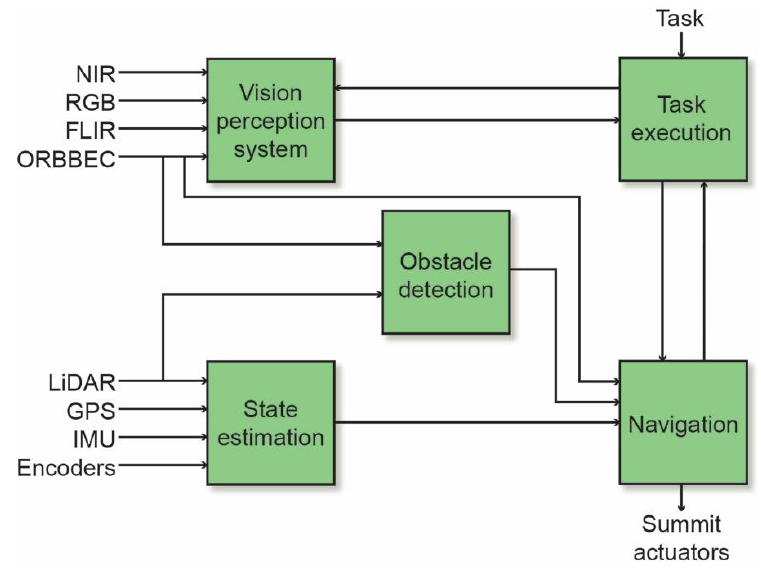
Figure 8. Wheeled mobile robot five main ROS packages and information flow. The task executor accepts the defined tasks regarding the motion and sends a task.